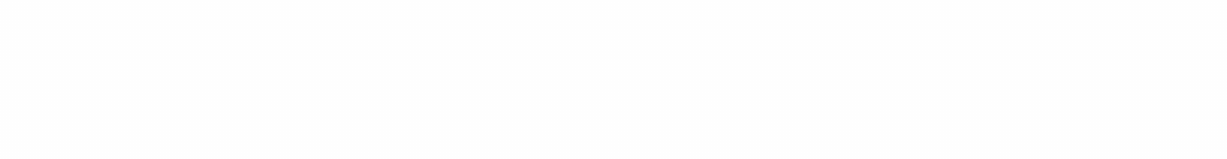
were collected after 10 days of culture and their